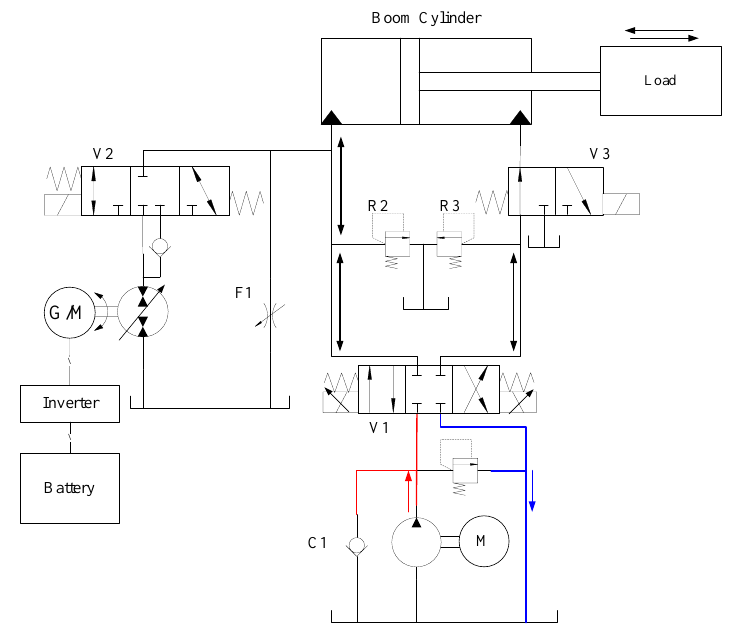
Figure 3. Working principle of normal mode.